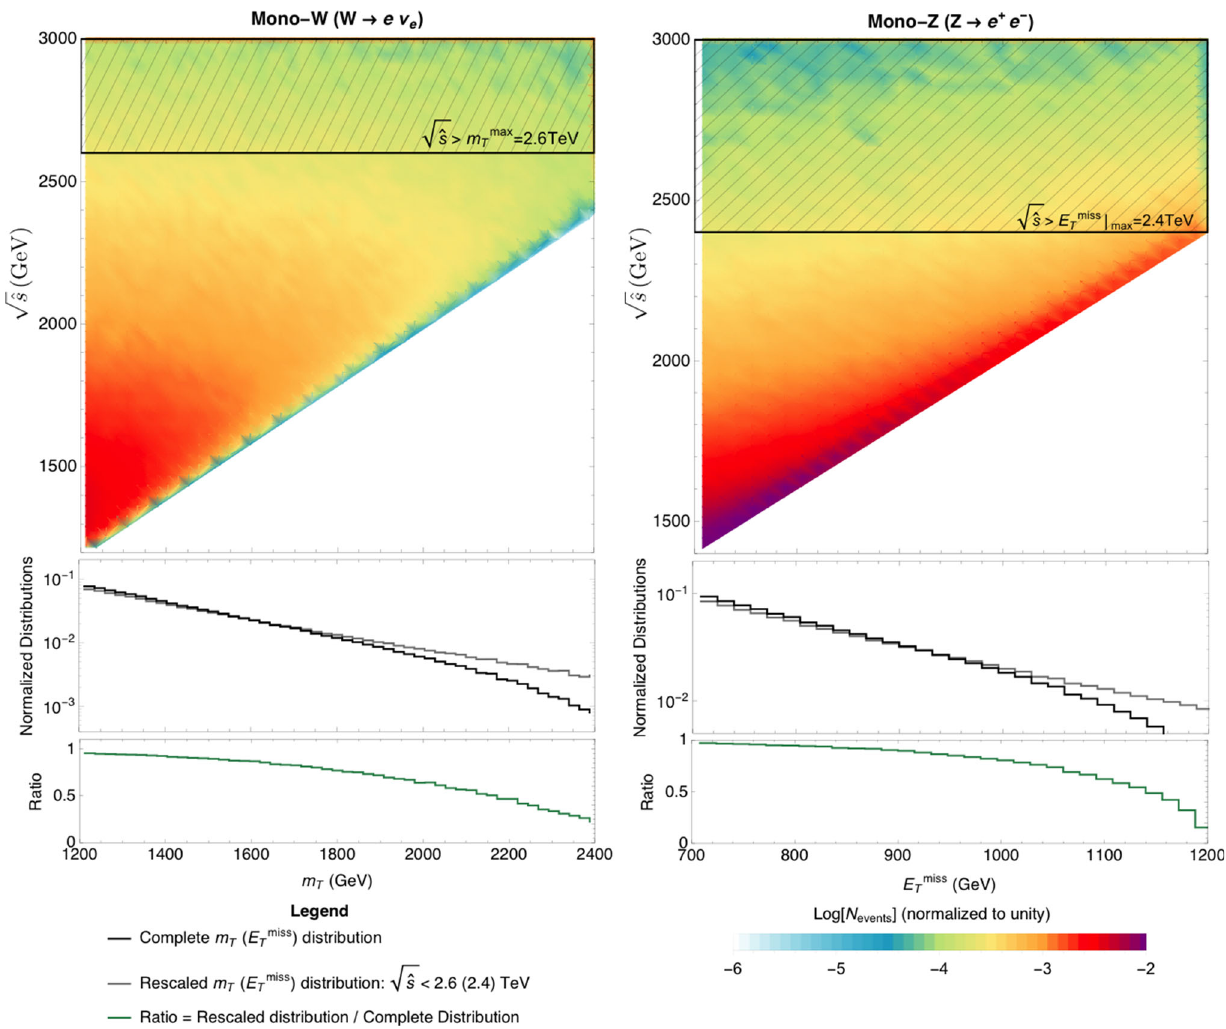
Fig. 4 The left ( right ) top panel shows the correlation between m T √ ˆ s for mono- W (mono- Z ) through a double-differential ( / E T ) and Monte Carlo distribution for the A ˜ signal. The centre plots show the W